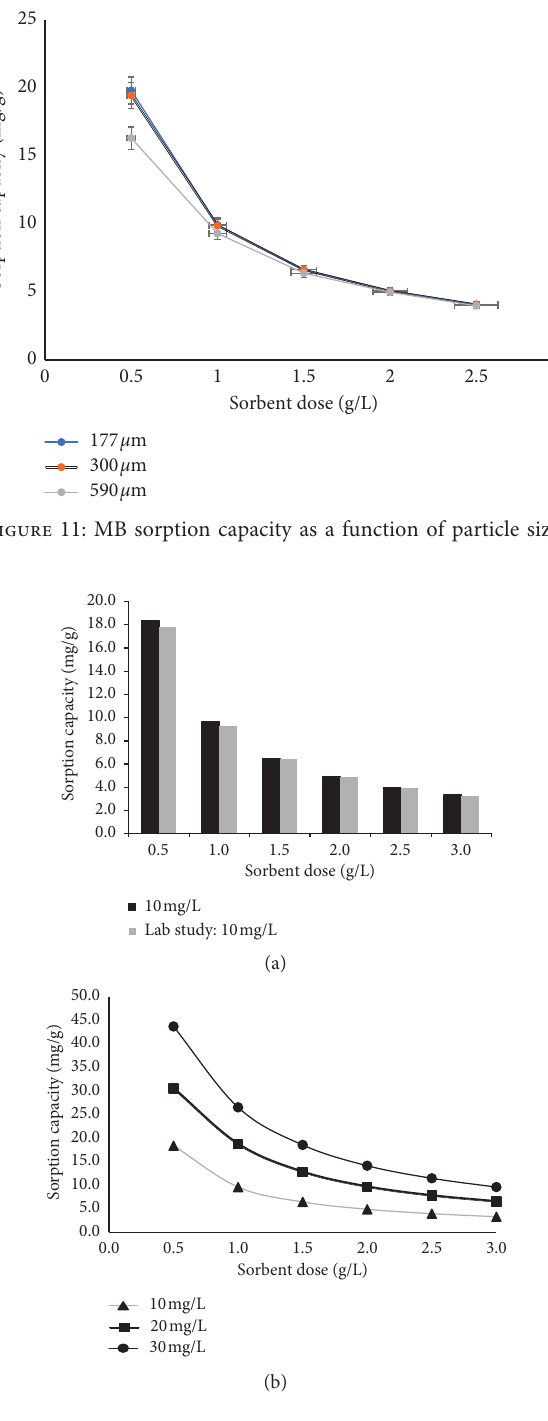
Figure 12: Matrix effect: comparative plot of Milli-Q and Dell pond water